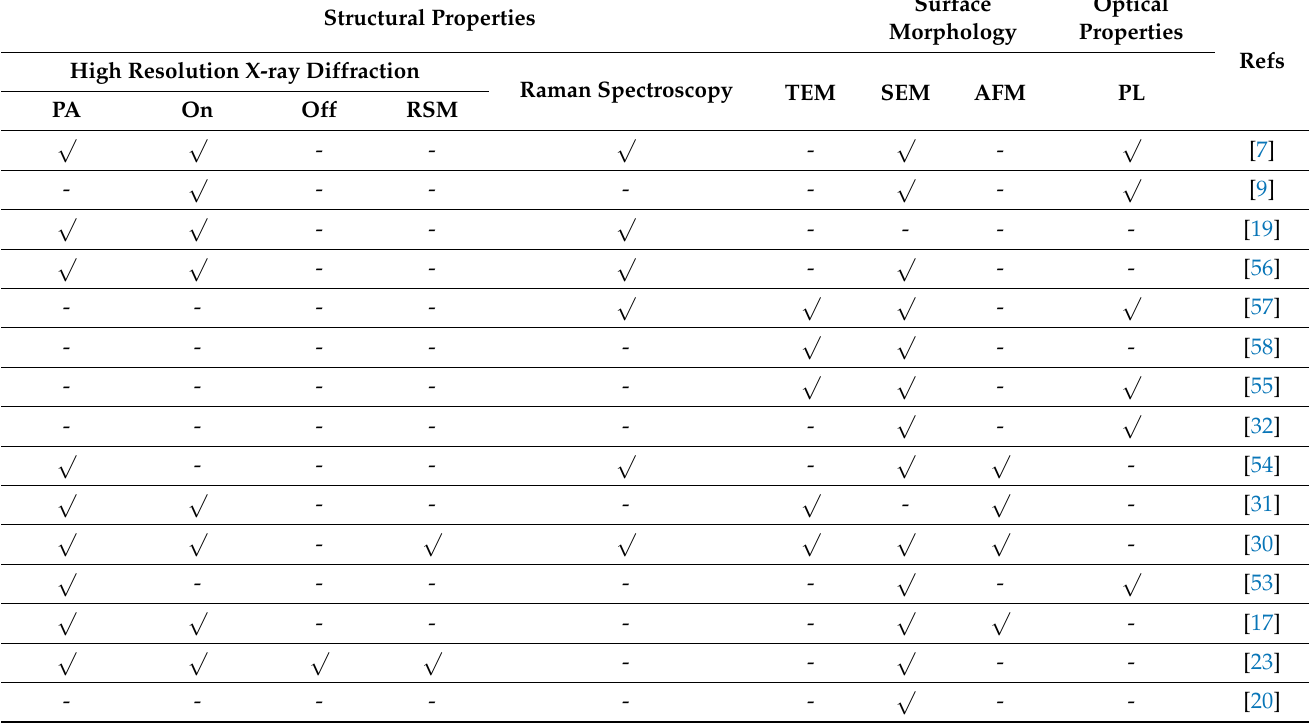
Table 3. Summary of structural, morphological, and optical